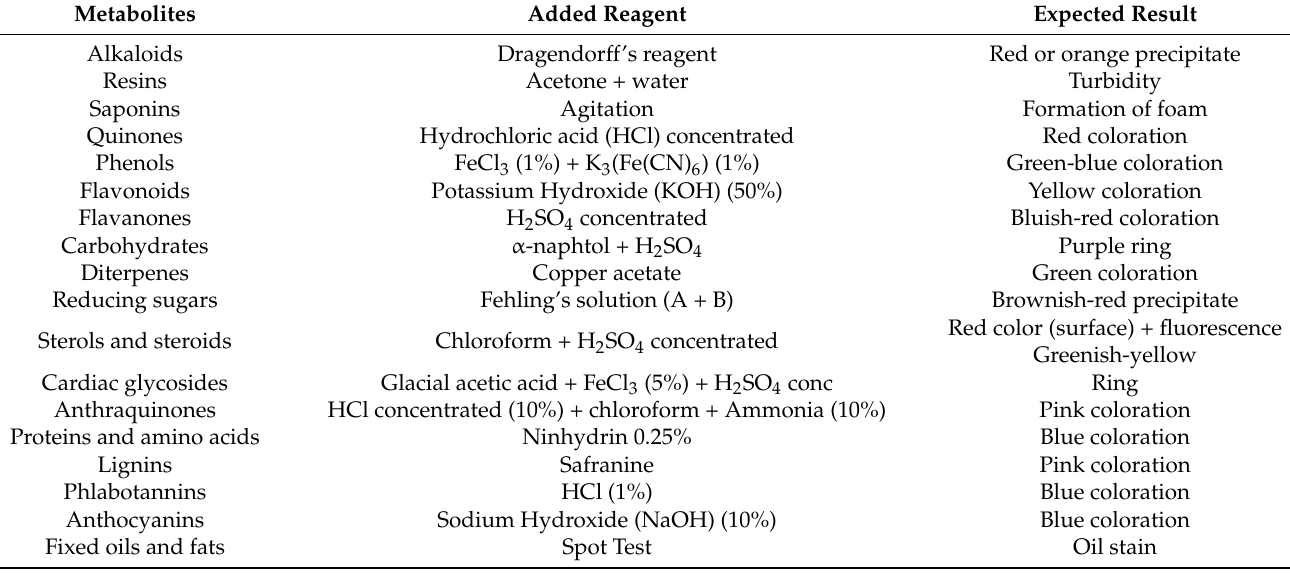
Table 1. Detection of primary and secondary metabolites in leaves of P. tetragonolobus